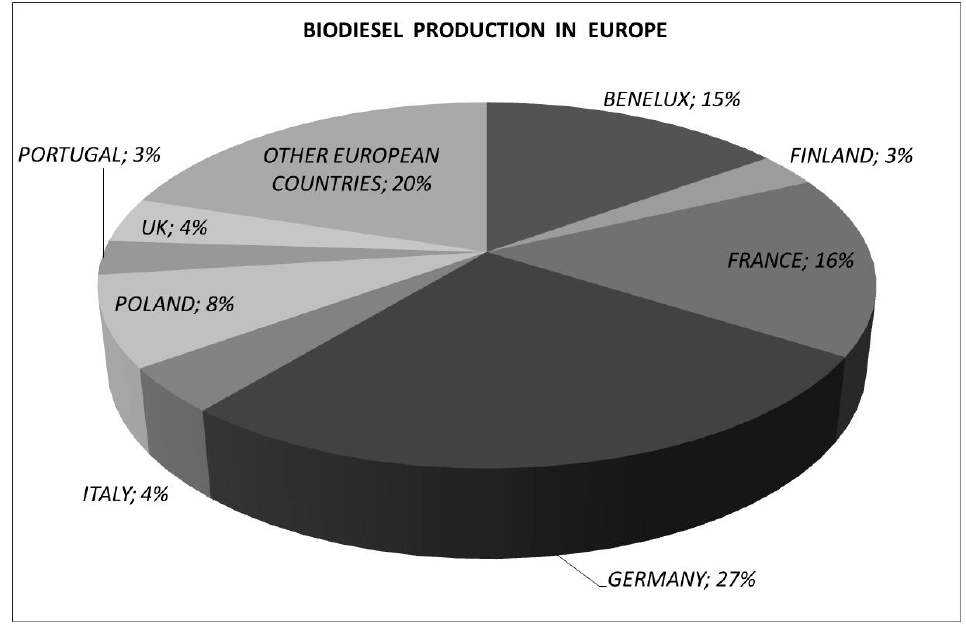
Figure 1. Biodiesel production in some countries in Europe in the last 10 years, readapted from [7].